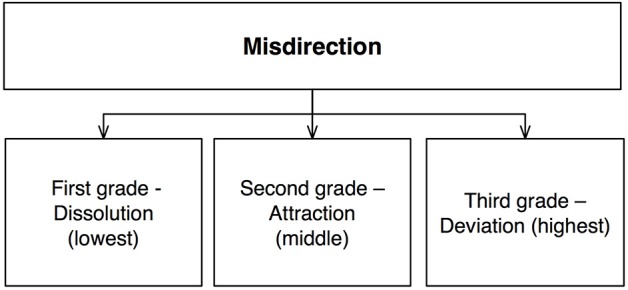
Schematic description of Ascanio's (1964) taxonomy.